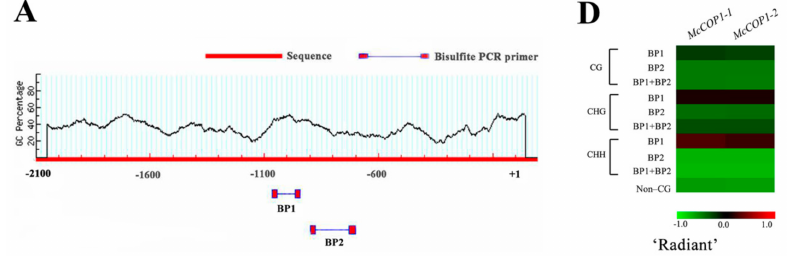
Figure 1. Anthocyanin abundance and transcript levels of McCOP1 during crabapple leave de- velopment. ( A ). Phenotypes of leaves at different growth stages of crabapple. The numbers 1–10 correspond to different leaf growth stages. ( B ). Anthocyanin content in crabapple leaves from the ten developmental stages, in µ g/g fresh weight (FW). ( C ). Relative McCOP1-1 expression levels in leaves from the 10 developmental stages of crabapple were determined using RT-qPCR. ( D ). Relative McCOP1-2 expression levels in leaves from the 10 developmental stages of crabapple were deter- mined using RT-qPCR. Bar = 1 cm. Real time (RT)-quantitative (q)PCR and high-pressure liquid chromatography (HPLC) were performed with three biological replicates. Error bars indicate the standard error of the mean ± SE of three replicate measurements. Different letters above the bars indi- cate significantly different values ( p < 0.05), calculated using one-way analysis of variance (ANOVA) followed by a Tukey’s multiple range test. Scale bar = 1